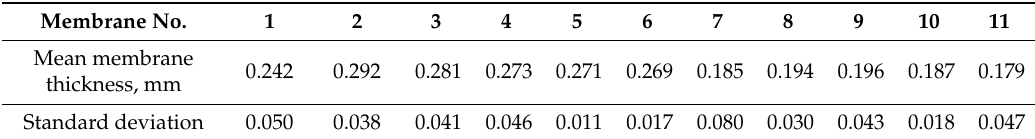
Table 5. Mean thickness of membrane test samples.